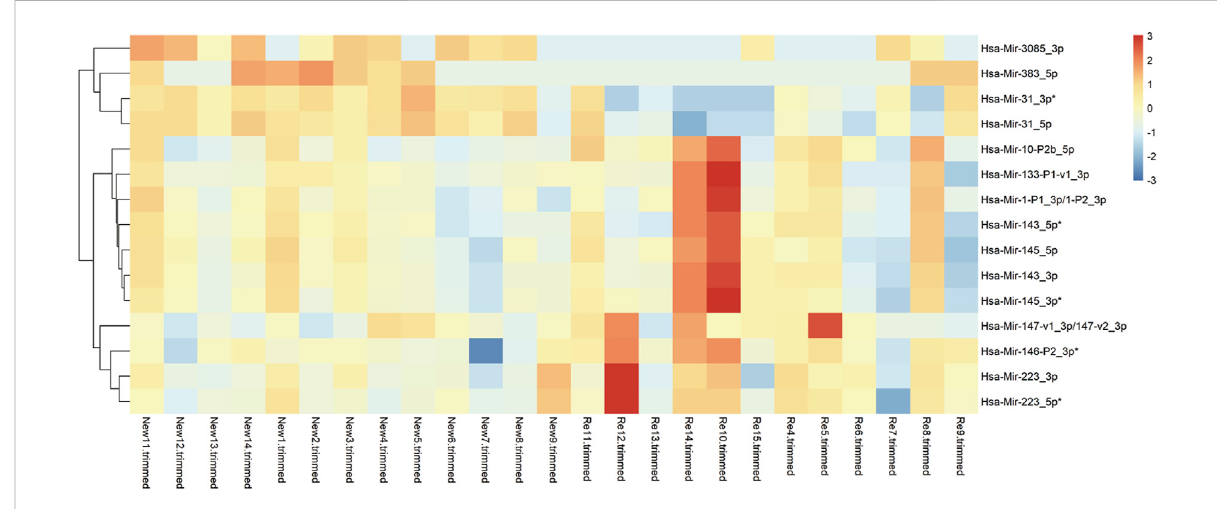
FIGURE 3 OverviewofmiRNA-seqresultsof12recurrenttumorsvs.13primarytumors. (A) AHeatmapshowingthetop15differentiallyexpressedmiRNAs in12 recurrentvs. 13 primary tumors.In recurrent BC, miR-3085-3p and miR-31-5p weresigni fi cantly down-regulated,while miR-223-3p and miR- 146-3p were